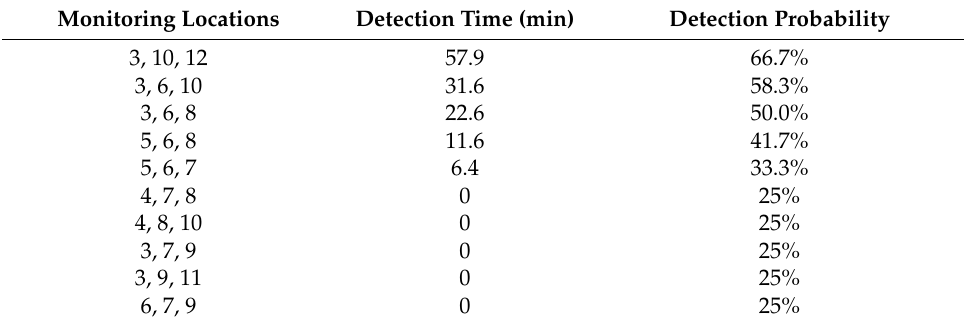
Algorithm 3 Pseudocode of Bidirectional Fitness Function